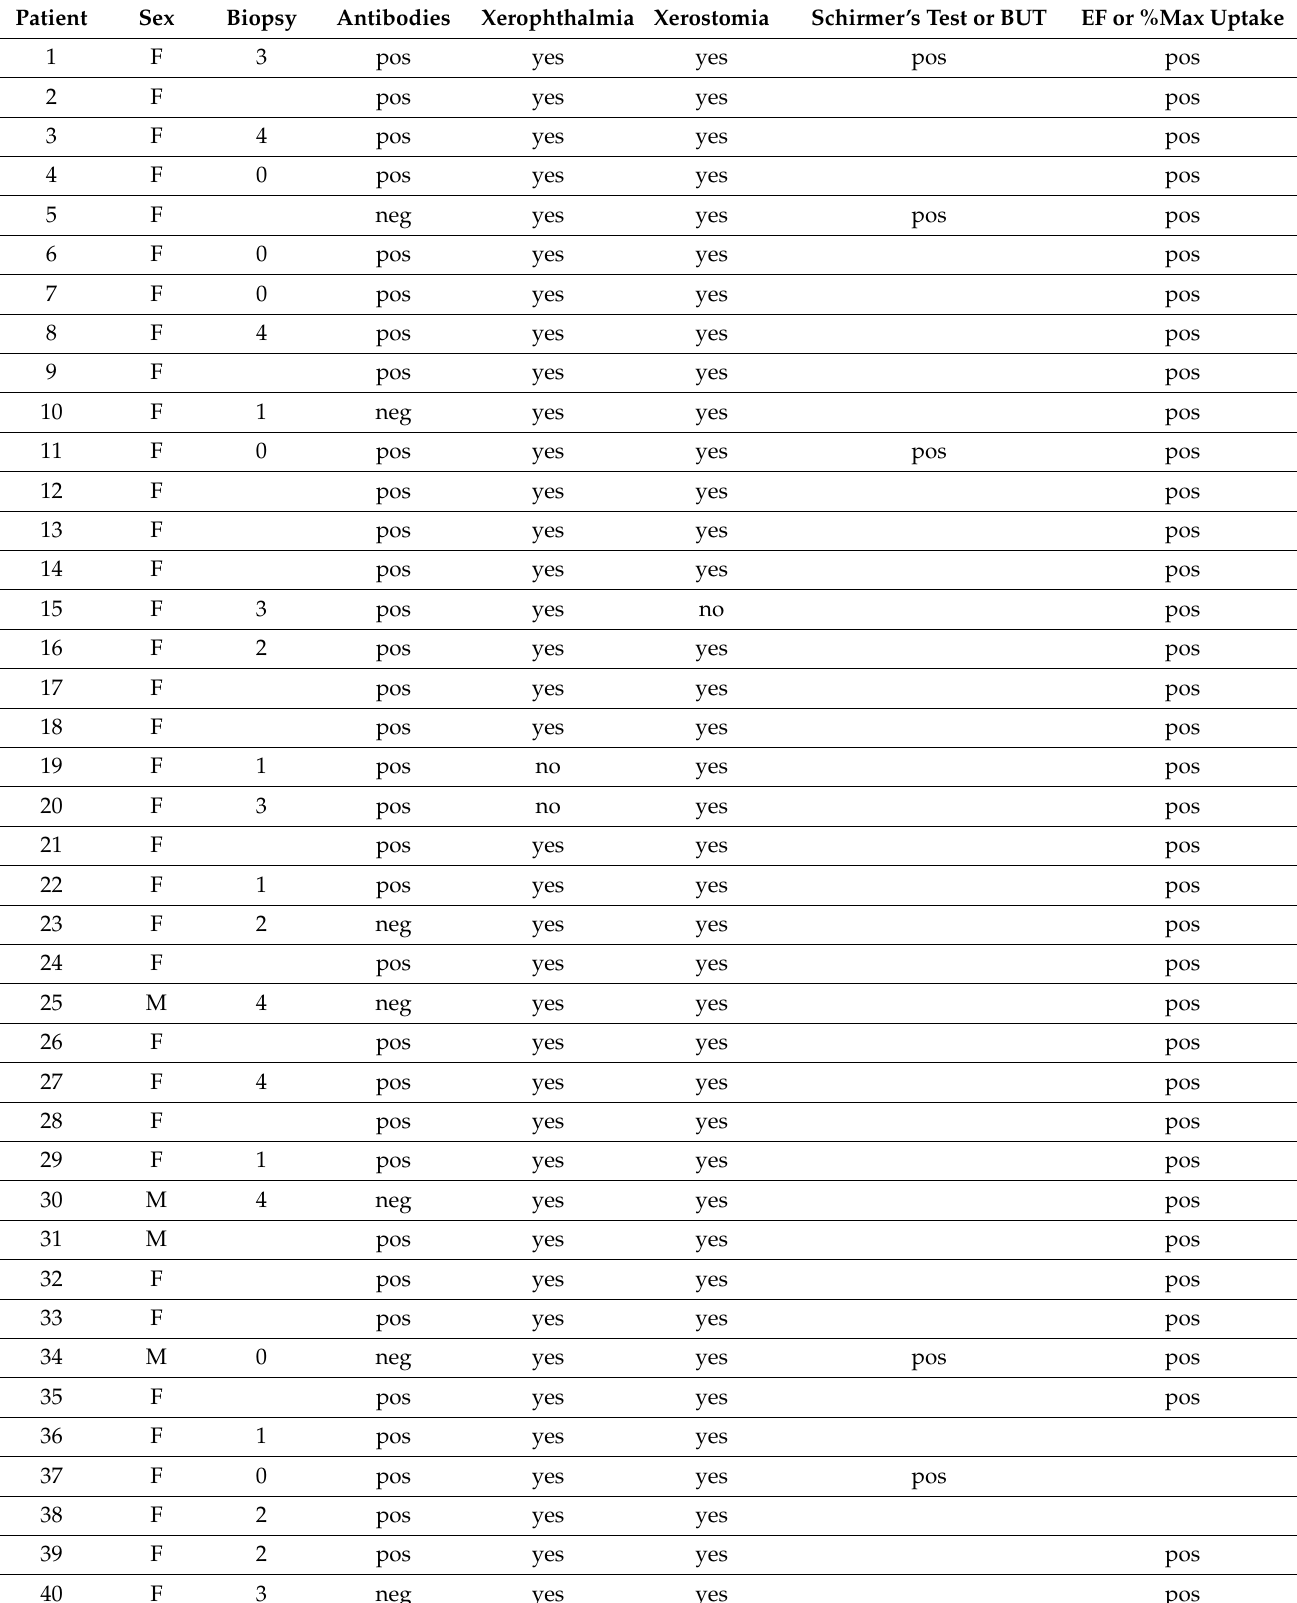
Table 1. Patient’s characteristics and the criteria for clinical